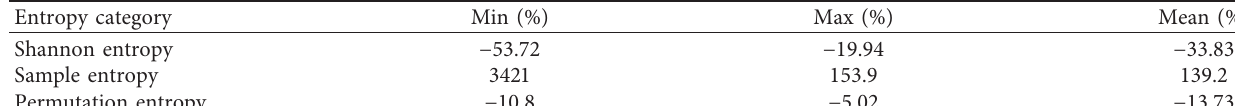
Table 5: Percentage difference.